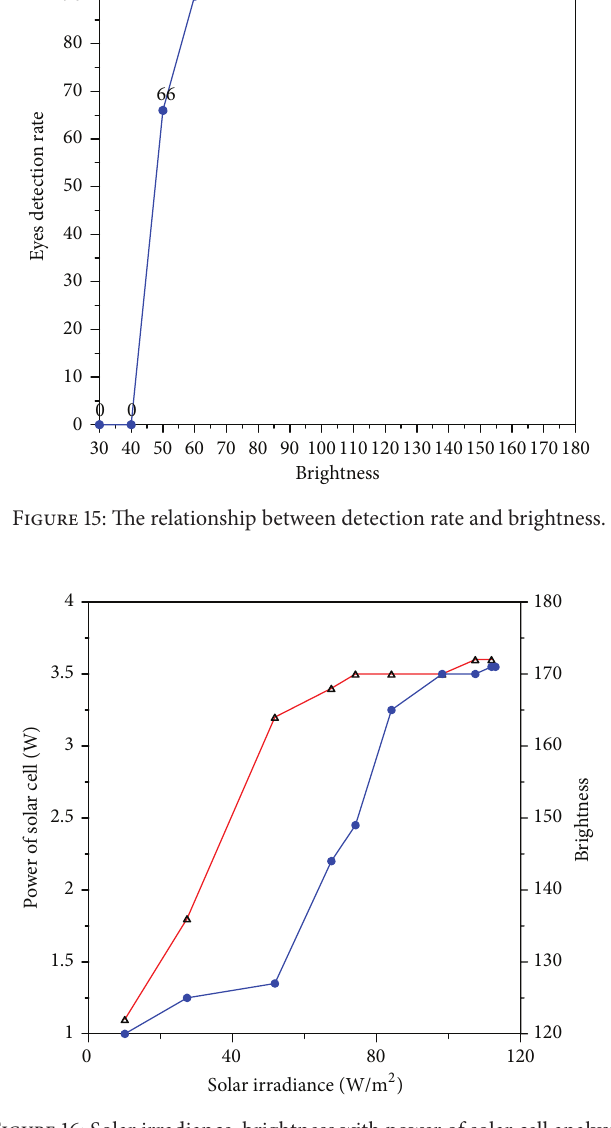
Detect and analysis